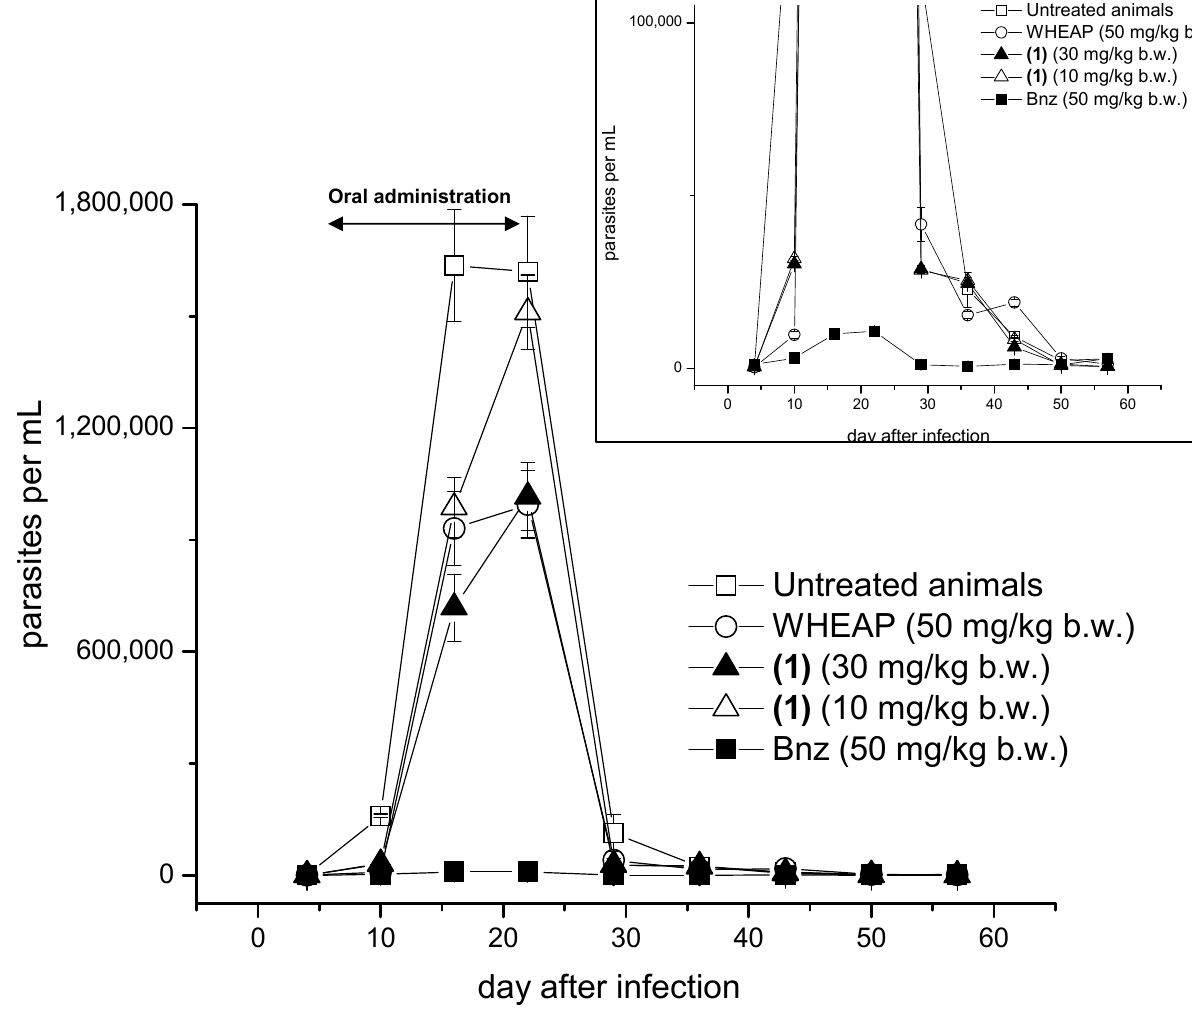
Figure 2. Parasitemia versus days post-infection in the in vivo activity assays (the oral administration was done between days 7 and 21). Eight animals were used in each experimental group. Inset: enlarged region showing the behavior of